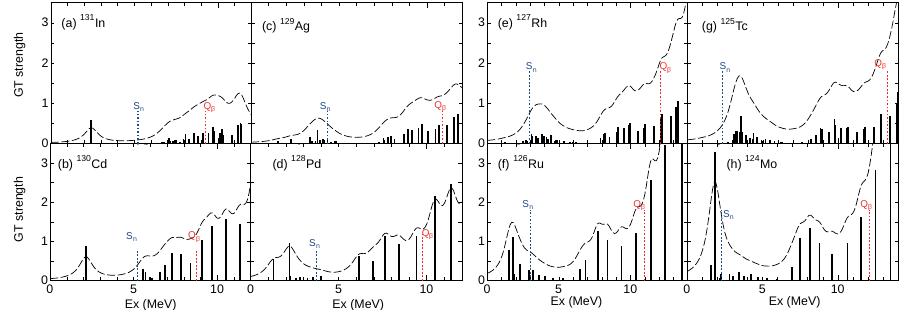
Figure 1. Gamow-Teller strength distribution of N = 82 isotones, (a) 131 In, (b) 130 Cd, (c) 129 Ag, (d) 128 Pd, (e) 127 Rh, (f) 126 Ru, (g) 125 Tc, and (h) 124 Mn, provided by the shell-model calculations. The blue and red dotted lines denote the neutron separation energies and Q-values, respectively. The dashed lines are the folded strength functions by a Lorentzian with 1-MeV width. Revised from Ref.